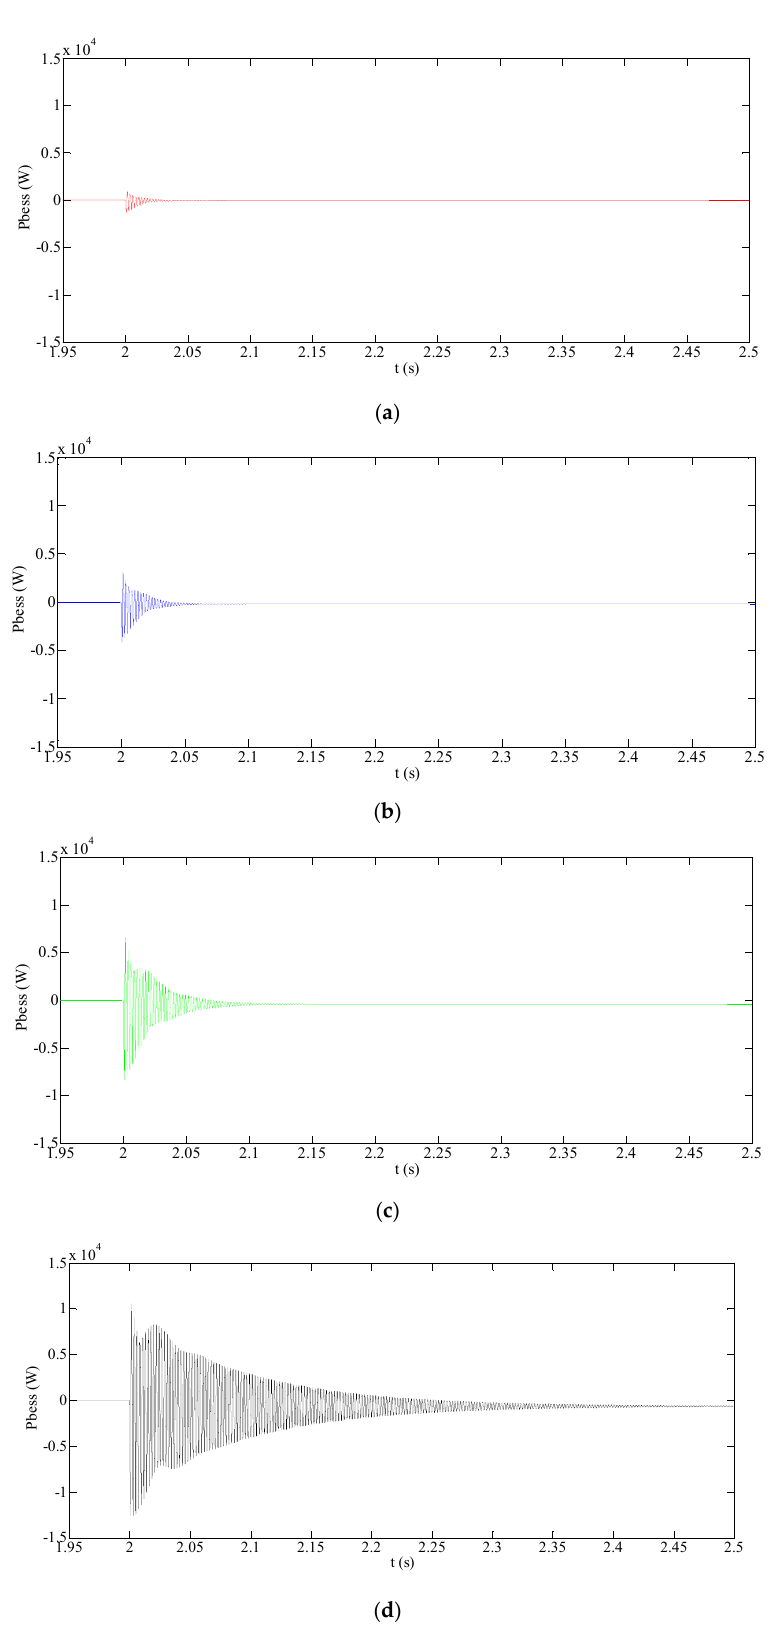
Figure 11. The curves of the additional power of the ESS: ( a ) P s changes from 90 kW to 100 kW; ( b ) P s changes from 90 kW to 120 kW; ( c ) P s changes from 90 kW to 150 kW; ( d ) P s changes from 90 kW to 180 kW.